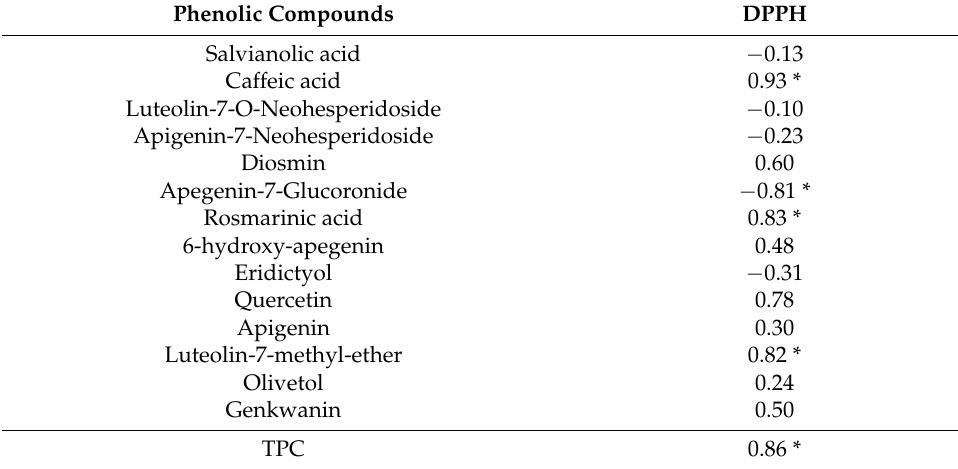
Table 3. Linear correlation coefficients established between phenolics and the DPPH antioxidant activity. Phenolic Compounds DPPH Salvianolic acid − 0.13 Caffeic